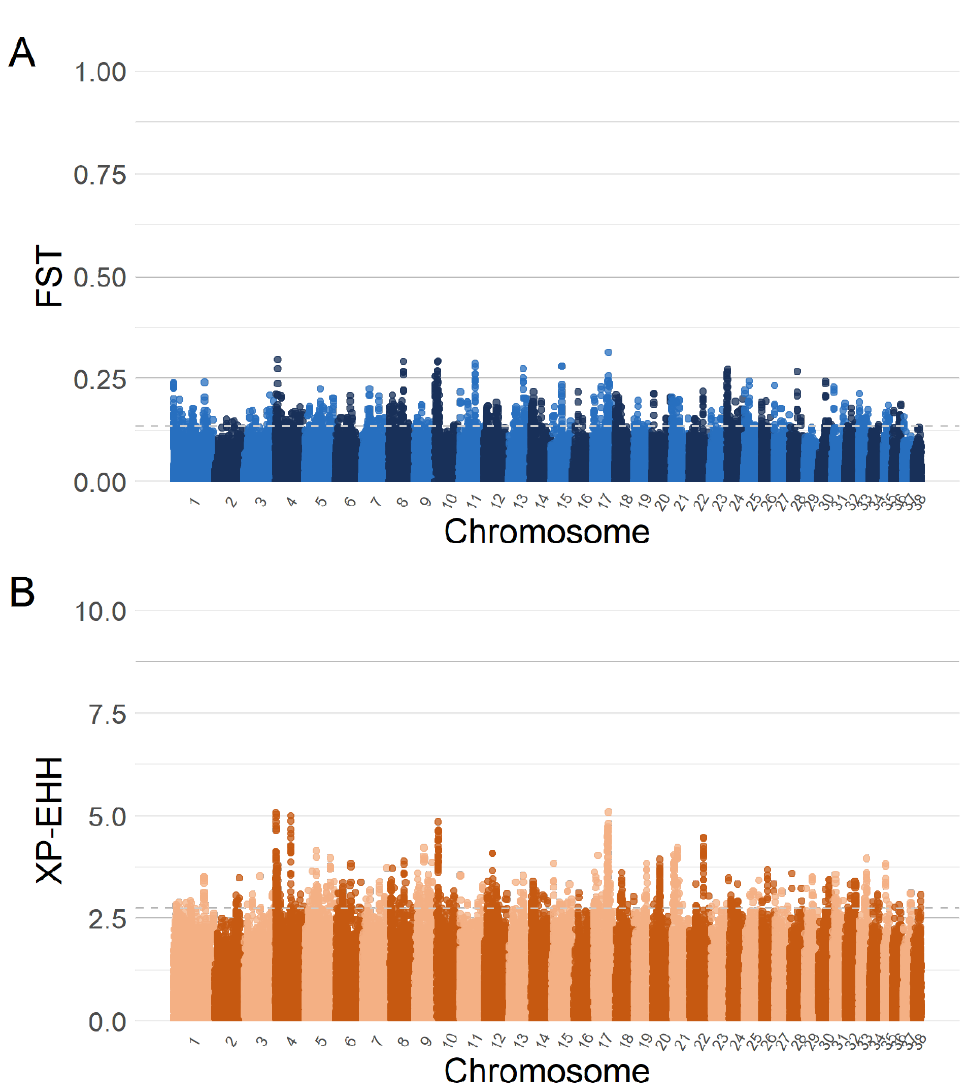
Figure 3. Manhattan plots of Wright’s fixation index ( F ST ) ( A ) and single SNP cross-population extended haplotype homozygosity (XP-EHH) ( B ) analyses comparing livestock guardian and herding shepherd dog breeds. Top 1% F ST absolute values ranged from 0.13 to 0.31, and top 1% log (XP-EHH) from 2.7 to 5.1, as indicated by the grey dashed lines. In cross-referencing the results of both analyses, we found 48 SNPs that mapped onto regions containing 29 different genes that were shared between the two (Table 1). Table 1. List of genes shared between Wright’s fixation index (F ST ) and single SNP cross-popula- tion extended haplotype homozygosity (XP-EHH) analyses comparing livestock guardian and herding shepherd dogs.